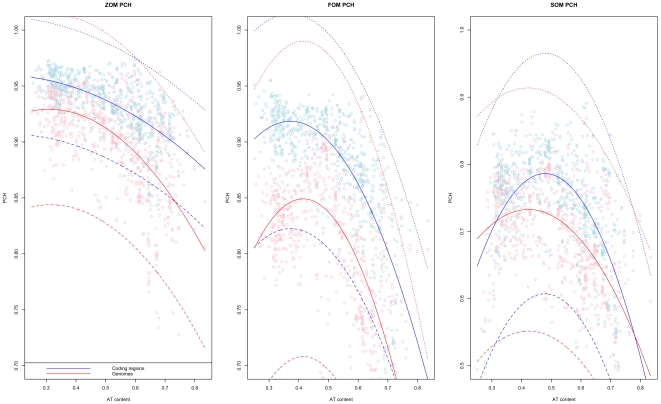
Markov chain model based PCH scores in prokaryotes.ZOM (left), FOM (middle) and SOM (right) PCH values (vertical axis) obtained for each chromosome sorted from left to right by increasing AT content (horizontal axis). The PCH scores show how the Markov chain based genomic signatures change, on average, within each chromosome. For all models we find that PCH scores are noticeably higher in coding regions (blue lines) than chromosomes, containing both coding and non-coding regions (red lines). Higher PCH values mean more homogeneous chromosomes while lower PCH means more heterogeneous chromosomes with respect to the corresponding Markov-chain based genomic signatures. Dotted lines represent 99% prediction intervals.